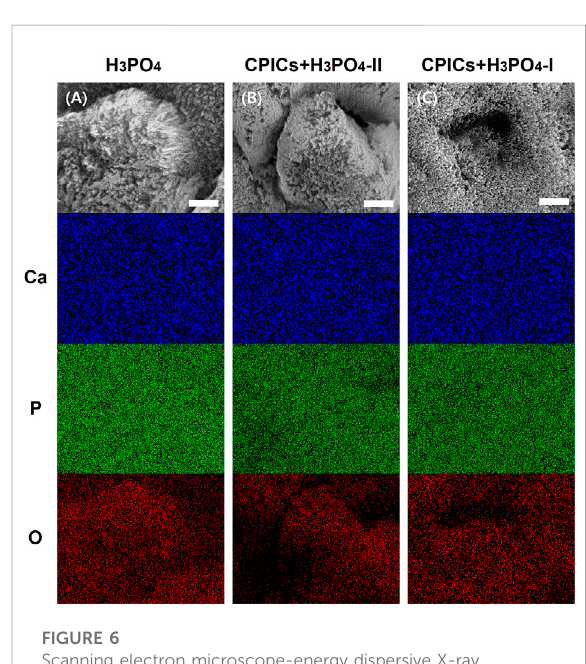
FIGURE 6 Scanning electron microscope-energy dispersive X-ray spectrometer (SEM-EDX) element mapping for the Ca, P, and O elements on the acid etched enamel specimens (A, control;